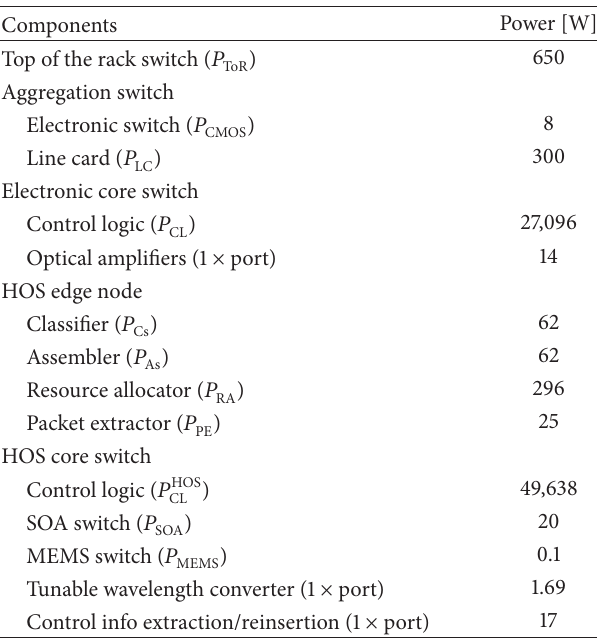
Table 1: Values of power consumption of the components within the optical ptp and the HOS data center